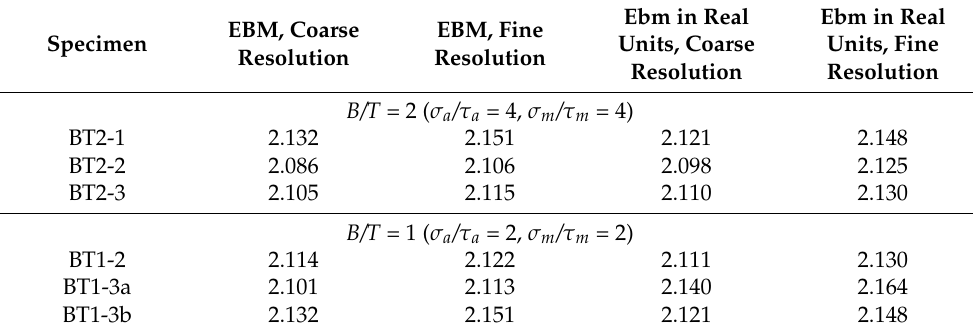
Table 8. Summary of the Df results, with four different calculation parameters.